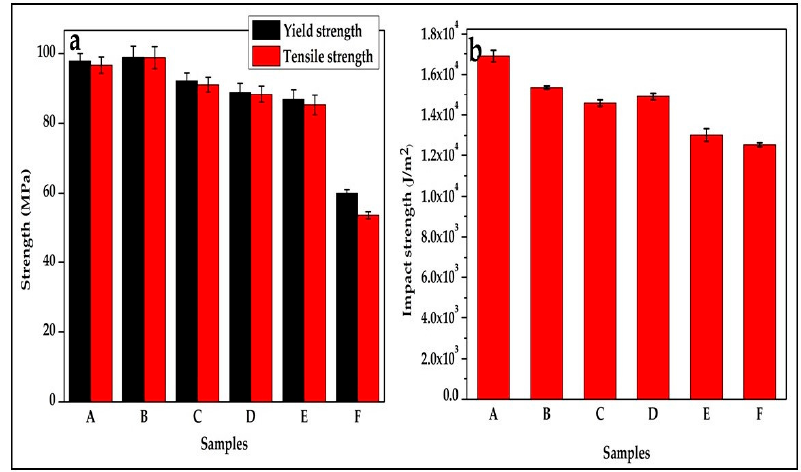
Figure 2. ( a ) Tensile properties and ( b ) Impact strength of samples A—92% polylactic acid (P) / 8% chitin (C); B—92% P / 6% C / 2% starch (S); C—92% P / 4% C / 4% S; D—92% P / 2% C / 6% S; E—92% P / 8% S; F—100% P.